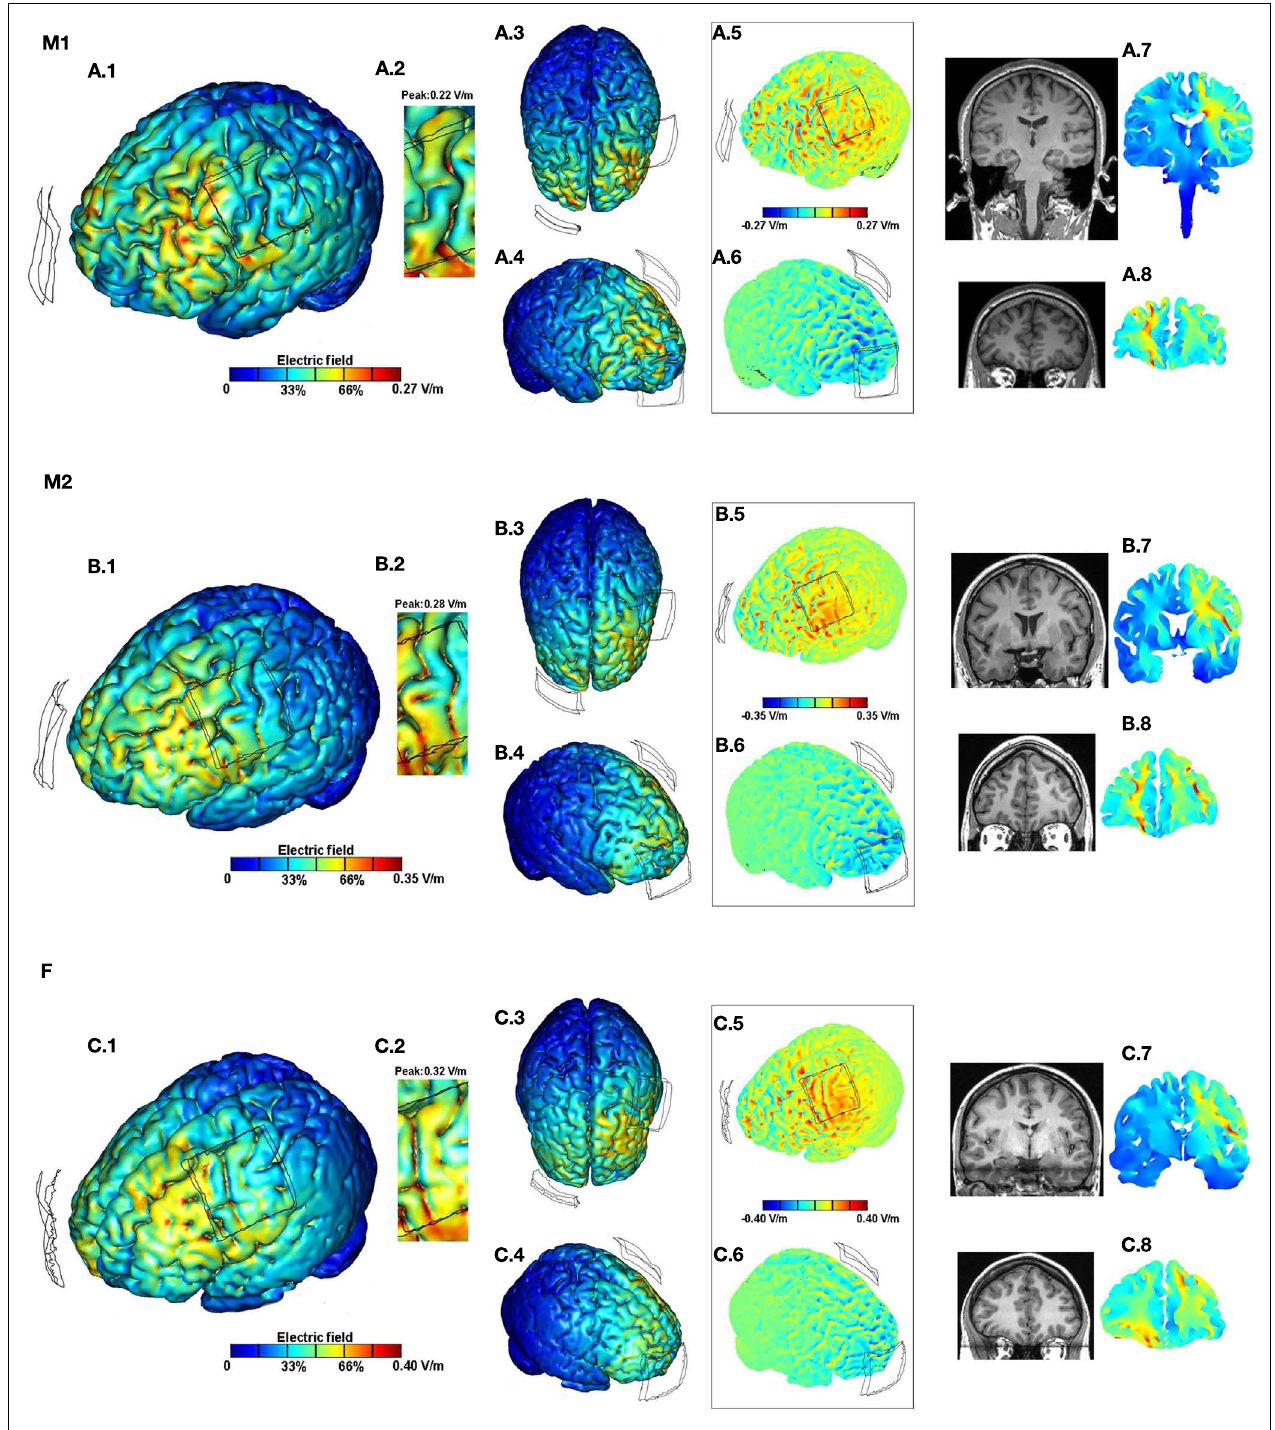
current flow (A.2,B.2,C.2) .The boxed images show the directional plots (A.5,A.6,B.5,B.6,C.5,C.6) . Sample cross-section EF magnitude plots were taken for the frontal and the motor regions.The corresponding MRI scan collected for the subject and the cross-section plots are shown juxtaposed to each other (A.7,A.8,B.7,B.8,C.7,C.8)